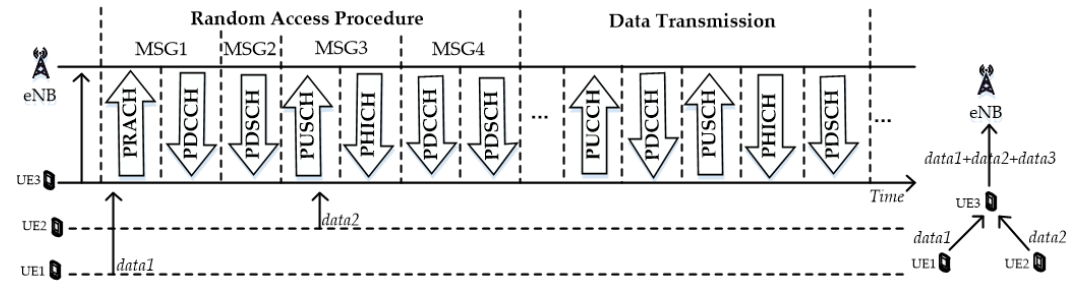
Figure 1. Signaling interaction and data transmission between device and base station.